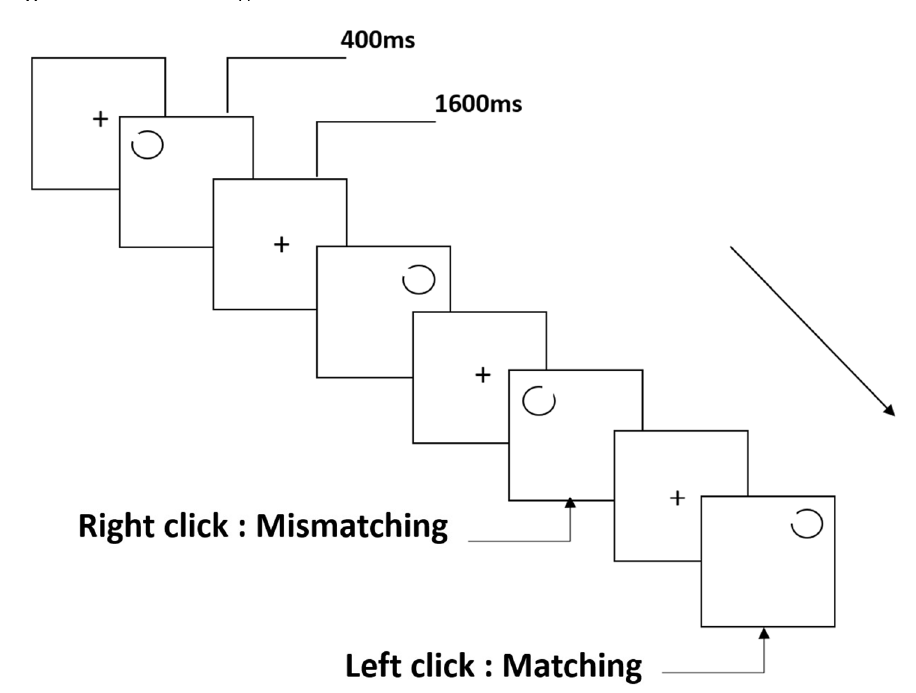
Figure 2. Schematic diagram of the rotating-notch circle task.